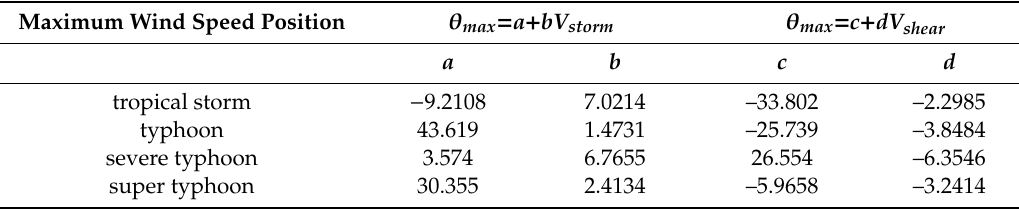
Table 4. Linear regression coe ffi cients for the maximum wind speed position ( θ max ) with respect to the typhoon translation speed ( V storm ) [ θ max = a + bV storm ] (Figure 9), and also with respect to the environmental vertical wind shear magnitude ( V shear ) [ θ max = c + dV shear ] (Figure 10) for di ff erent storm intensity